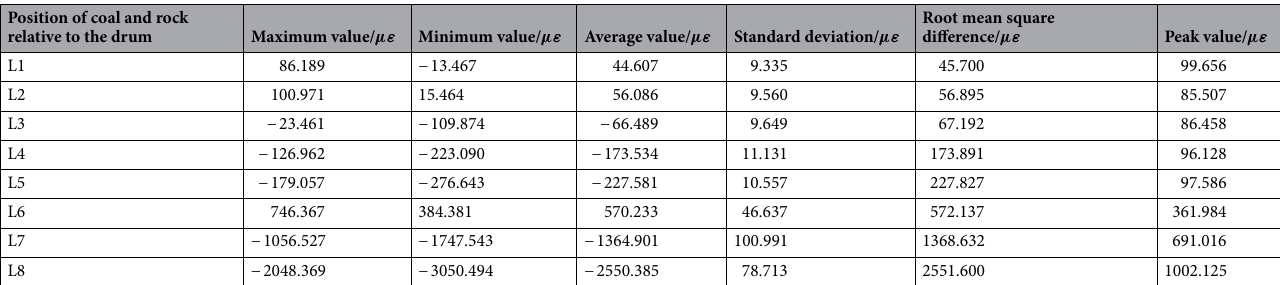
Table 2. Statistical results of coal and rock strain data.